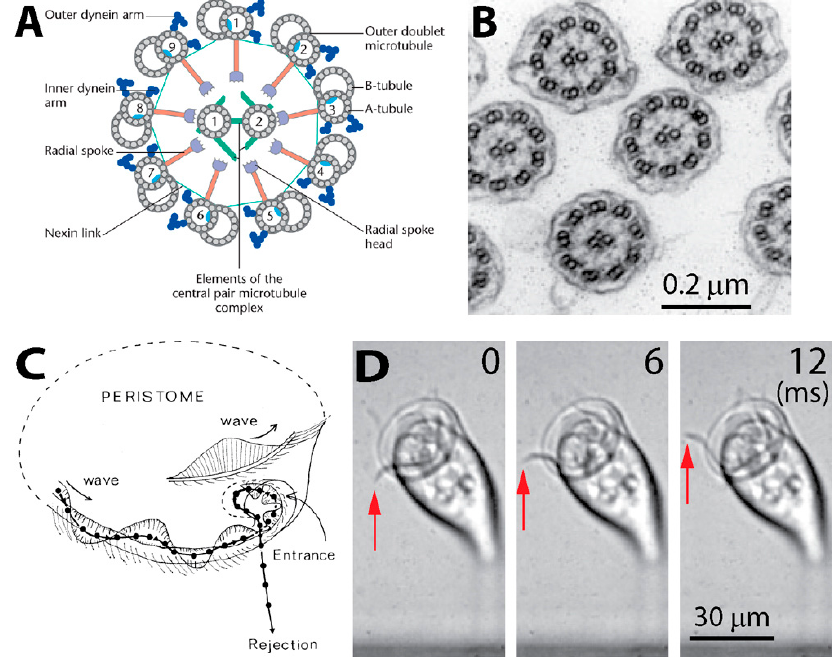
Figure 3. Oral cilia of Vorticella . ( A ) Cross-sectional view of the common structure of the cilium (reproduced from [63]). A cilium consists of nine circumferential doublet microtubules and one central pair of single microtubules (9 + 2 pattern). Dynein arms generate sliding motions between doublet microtubules, which bends the cilium; ( B ) cross-sectional view of the cilia of Vorticella . (reproduced from [67,68]); ( C ) a metachronal wave of cilia around the oral part of Vorticella (reproduced from [5]). The motion of the black particle shows transport of particles near the peristome; ( D ) red arrows show the metachronal ciliary wave of V. convallaria .